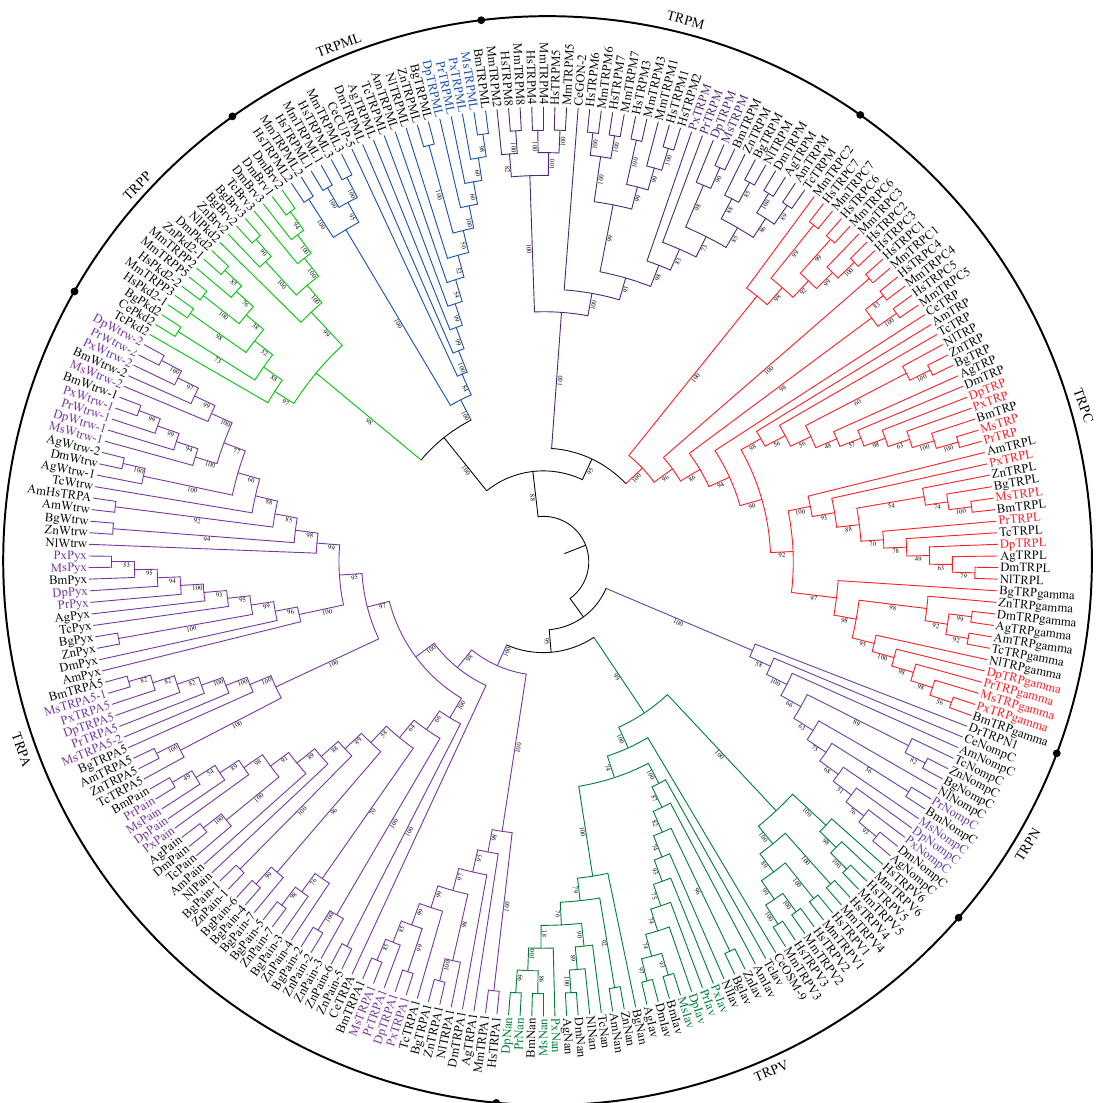
Figure 1. Phylogenetic analysis of TRP channels in P. rapae , D. plexippus , P. Xuthus , M. sexta , B. mori and other organisms. Amino acid sequences of P. rapae (Pr), D. plexippus (Dp), P. Xuthus (Px), M. sexta (Ms), B. mori (Bm), B. germanica (Bg), Z. nevadensis (Zn), N. lugens (Nl), Apis mellifera (Am), D. melanogaster (Dm), A. gambiae (Ag), Tribolium castaneum (Tc), Caenorhabditis elegans (Ce), Homo sapiens (Hs), Danio rerio (Dr) and Mus musculus (Mm) TRP channels were aligned through MAFFT software v7.123b with the default parameters [18]. Under the LG + G4 nucleotide substitution model, IQ-TREE was applied for the maximum likelihood analyses with 1000 bootstrap replicates [19]. The bootstrap value is indicated next to each branch. The accession number of TRP channels identified in this study are listed in an Additional file (Table S3). Other accession numbers of identified TRP channels originated from previous studies [26,27] . Table 2. Number of TRP channels identified in P. rapae , P. Xuthus , D. plexippus , M. sexta , Z. nevadensis , B. germanica , N. lugens and previous reports [26,27].